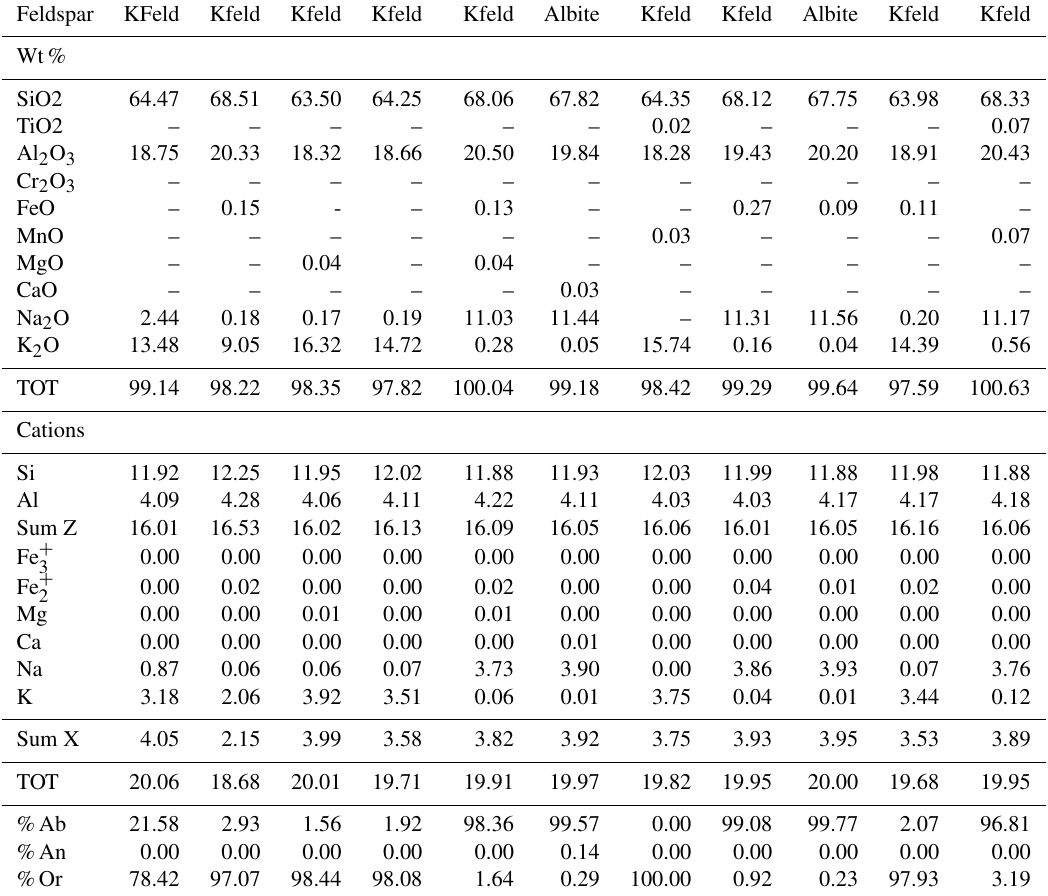
Table 3. Representative microprobe analyses for K-Feldpars and albites which were calculated assuming 8 oxygens. Feldspar